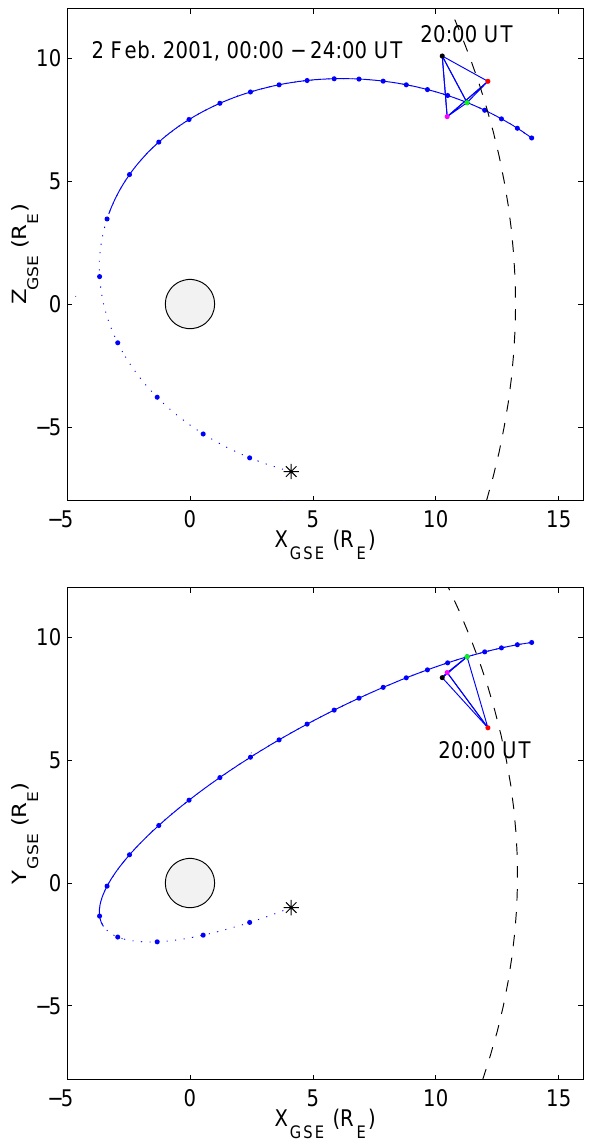
Fig. 3. The Cluster orbit track and spacecraft configuration pro- jected onto the X – Z GSE plane (top) and the X – Y GSE plane (bot- tom). The orbit is shown in a dotted line when the third component is negative. The asterisk indicates the start of the interval. Filled cir- cles indicate hourly markers along the orbit. The tetrahedron con- figuration is plotted on the orbit at around the time that the shock was encountered, expanded by a factor of 20 with the spacecraft in- dicated by black (Cluster 1), red (2), green (3) and magneta (4). A cut through a nominal bow shock location is shown on each panel for context.